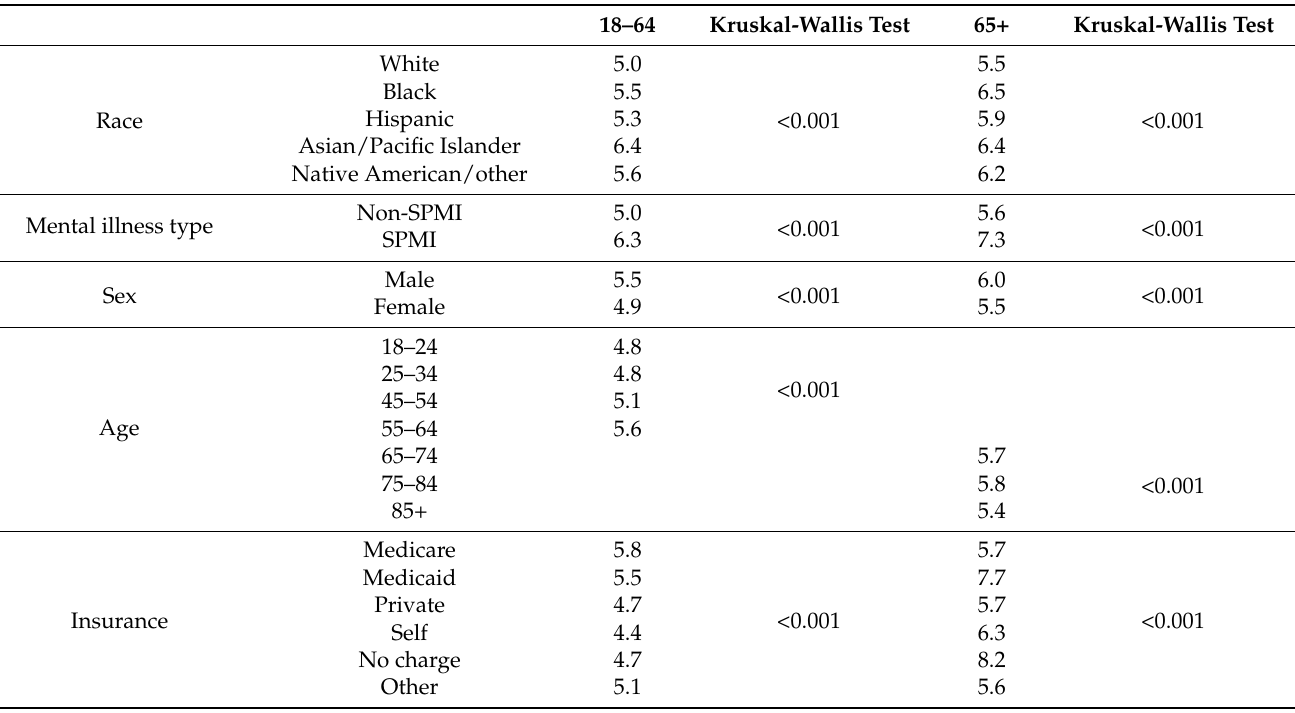
Table 2. Mean LOS by Sample Characteristics